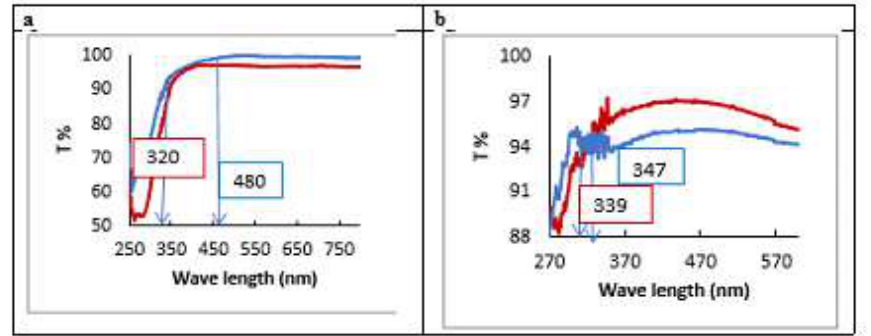
Figure (1): The optical transmittance for nanoparticles, a: vanadium pentoxide; b: tin dioxide; annealing at different temperatures (90 °C and 500